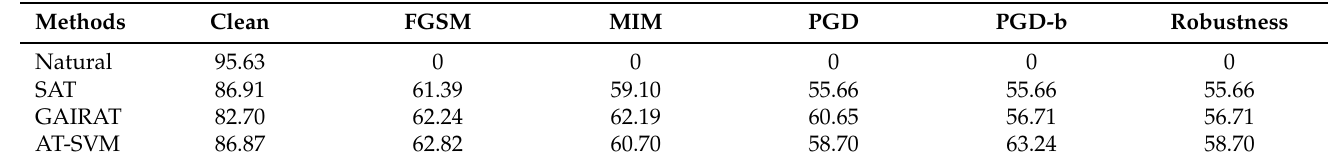
Table 3. Test accuracy of WideResNet-34-10 on the CIFAR-10